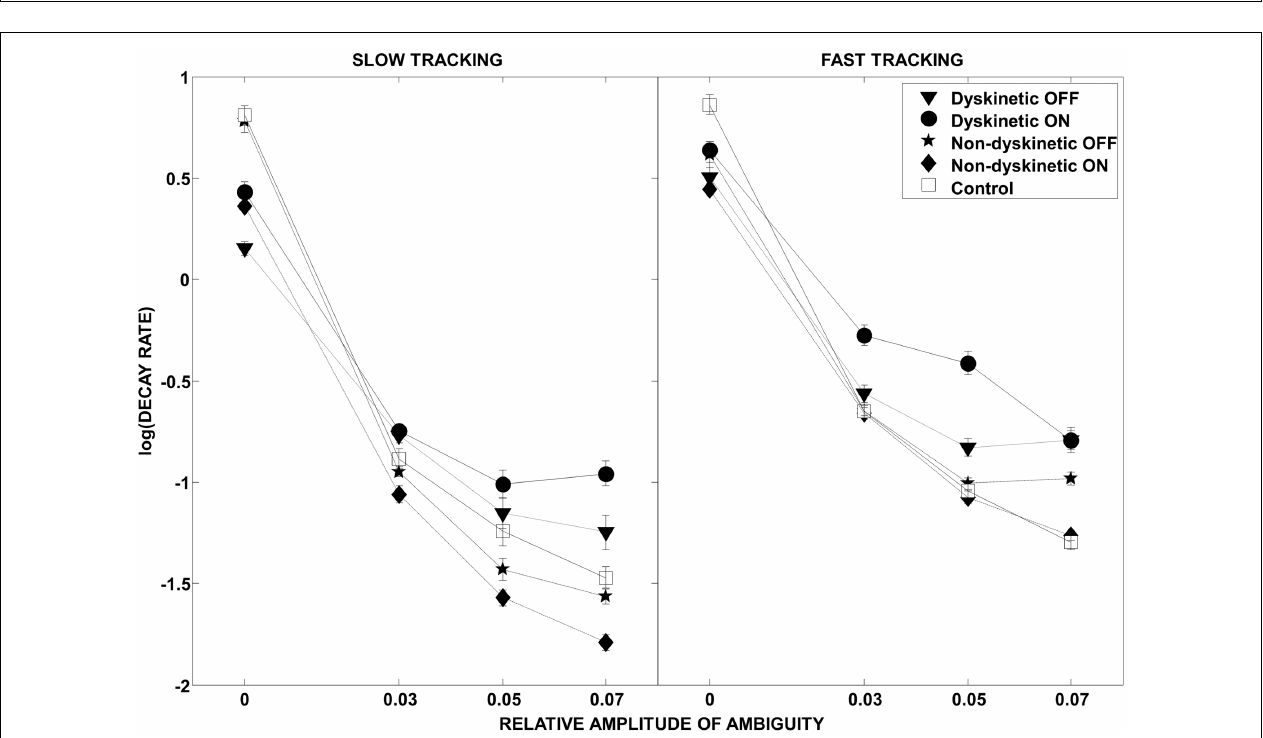
FIGURE 3 | Root mean square error as a function of visual ambiguity and tracking speed . Differences in RMS error in the low tracking speed condition (left panel) and high tracking speed condition (right panel) are shown. Error bars were estimated by leave-one-out-validation.